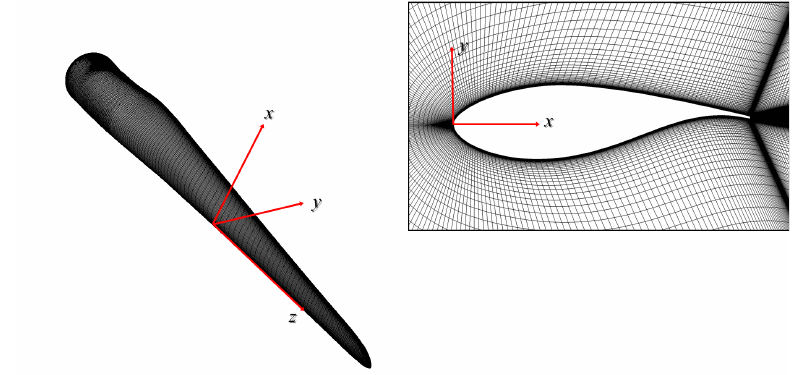
Figure 5. Surface mesh and detailed cross-section mesh of the blade. Variables x , y and z represent local coordinate of the blade section in the rotating frame of